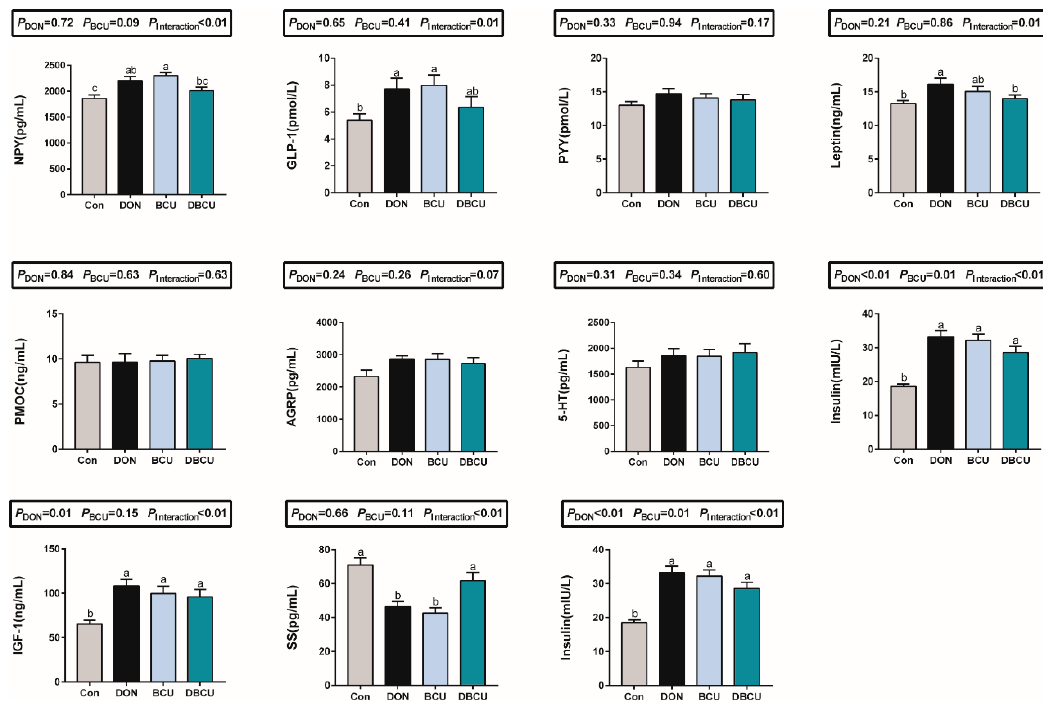
Figure 5. E ff ects of dietary DON and BCU on serum hormone in piglets. Values are means ± Figure 5. Effects of dietary DON and BCU on serum hormone in piglets. Values are means ± SEMs, n = SEMs, n = 7. Di ff erent letters in the picture represent di ff erences, p < 0.05. Basal diet (Con); 4 mg 7. Different letters in the picture represent differences, p < 0.05. Basal diet (Con); 4 mg DON/kg diet DON / kg diet (DON); 5 g BCU / kg diet (BCU); 5 g BCU / kg with 4 mg DON / kg diet (DBCU). IGF1: (DON); 5 g BCU/kg diet (BCU); 5 g BCU/kg with 4 mg DON/kg diet (DBCU). IGF1: insulin-like growth insulin-like growth factor 1; SS: somatostatin; GH: growth hormone; PYY: peptide YY; PMOC: factor 1; SS: somatostatin; GH: growth hormone; PYY: peptide YY; PMOC: proopiomelanocortin; GLP1: proopiomelanocortin; GLP1: glucagon-like peptide-1; NPY: neuropeptide Y; AGRP: agouti related glucagon-like peptide-1; NPY: neuropeptide Y; AGRP: agouti related protein; 5-HT: 5- protein; 5-HT: hydroxytryptamine.